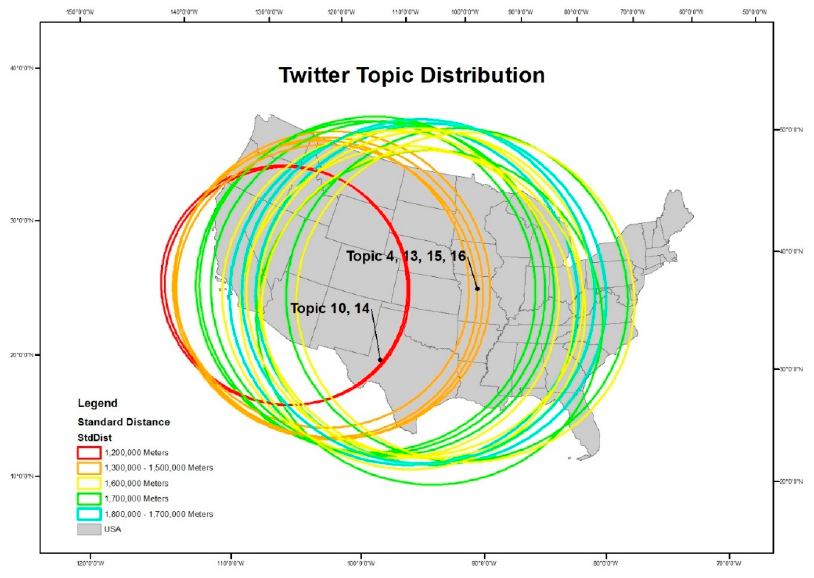
Figure 11. Twitter topic distribution in the USA.